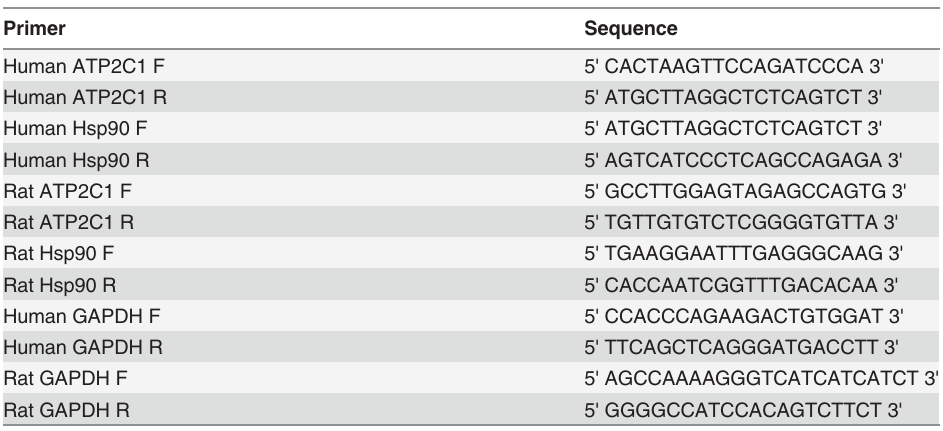
Table 1. Real Time PCR primers.